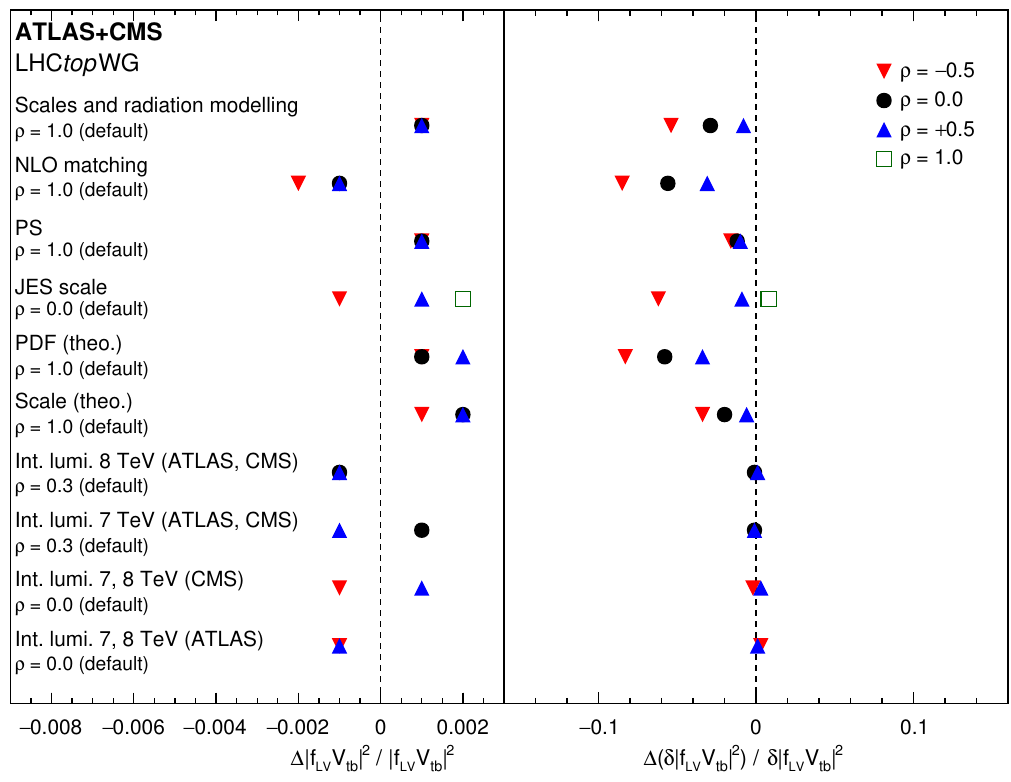
Figure 5 . Results of the stability tests performed by varying of the correlation assumptions in di(cid:11)erent uncertainty categories: theory modelling (scales and radiation modelling, NLO matching, and PS and hadronisation), JES, dominant theoretical cross-section predictions (i.e. PDF+ (cid:11) s